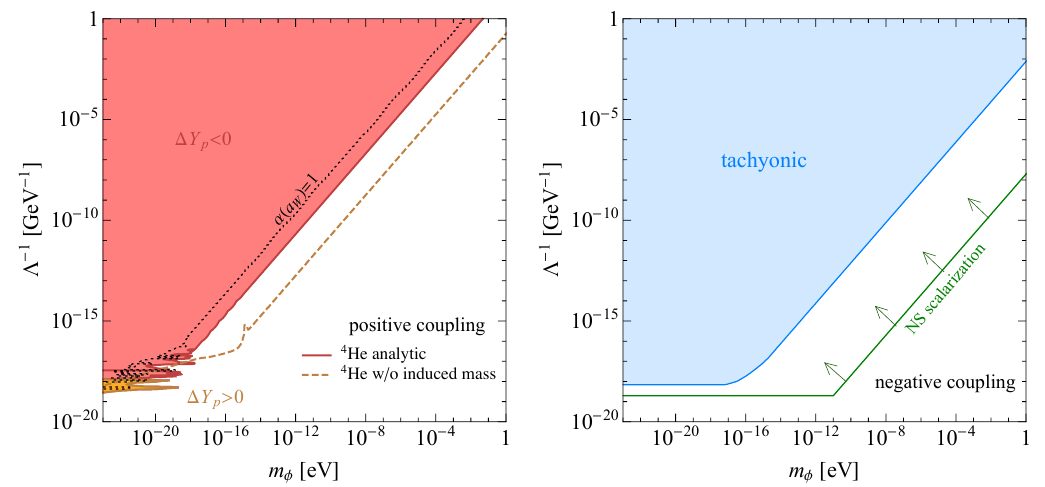
Figure 3 : Left: BBN constraints on the scalar dark matter parameter space in the case of positive coupling α = + φ 2 / Λ 2 . The shaded region is excluded at 95%CL. The red shading corresponds to underproduction of 4 He while the orange shading corresponds to overpro- duction. Orange dashed line shows the constraint obtained in an analysis that neglects the induced dark matter mass and uses instantaneous weak freeze-out approximation. For the parameters to the left of the black dotted line the coupling α becomes non-perturbative at the time of weak freeze-out (scale factor a = 10 − 9 . 6 ). Right: parameter space of the W model with negative coupling α = − φ 2 / Λ 2 . The blue shaded region corresponds to tachy- onic instability during BBN. It is excluded unless the initial conditions for dark matter are extremely fine-tuned. The region above the green line admits spontaneous scalarization of neutron